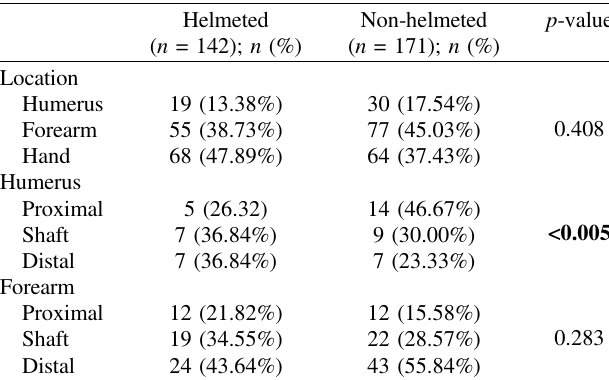
Table 1. Demographics and injury characteristics of patients involved in an MCC with an upper extremity